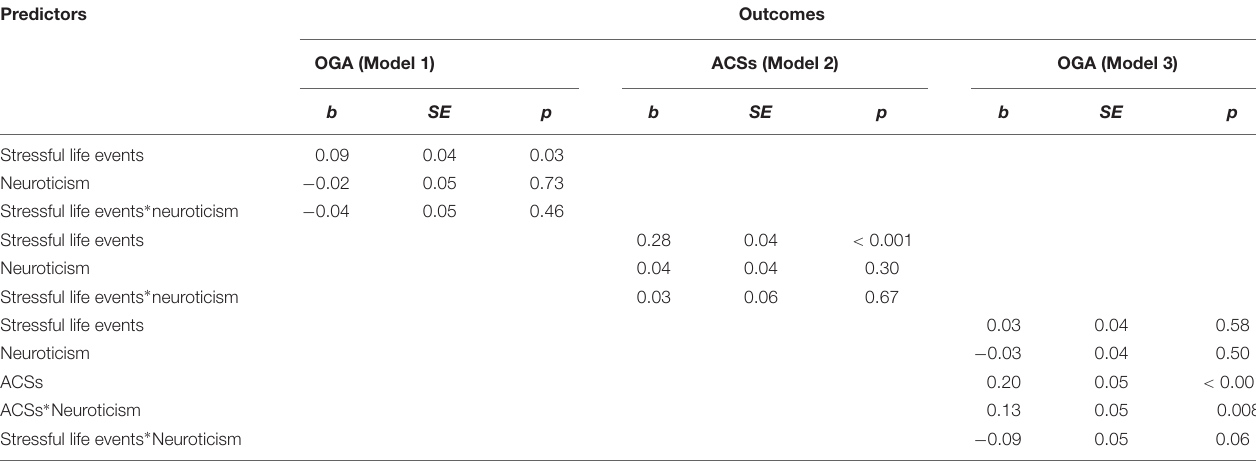
TABLE 4 | Model for the moderated-mediation hypothesis.